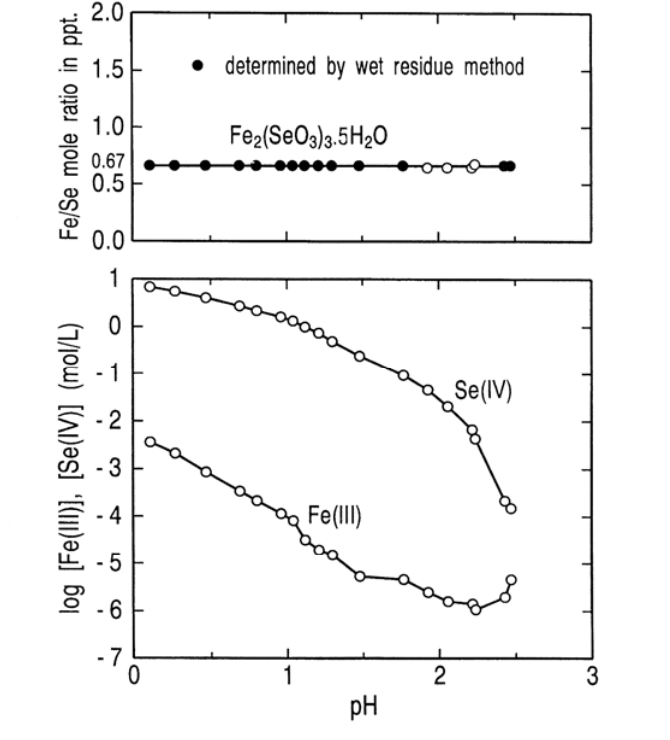
Figure 2. Stability and solubility regions for ferric selenite as a function of pH at 25